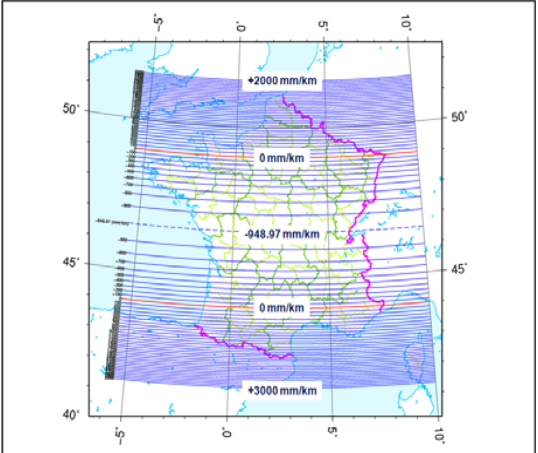
Figure 7: Scale factor of the RGF Lambert93 projection. Source: IGN-SGN/SICA,